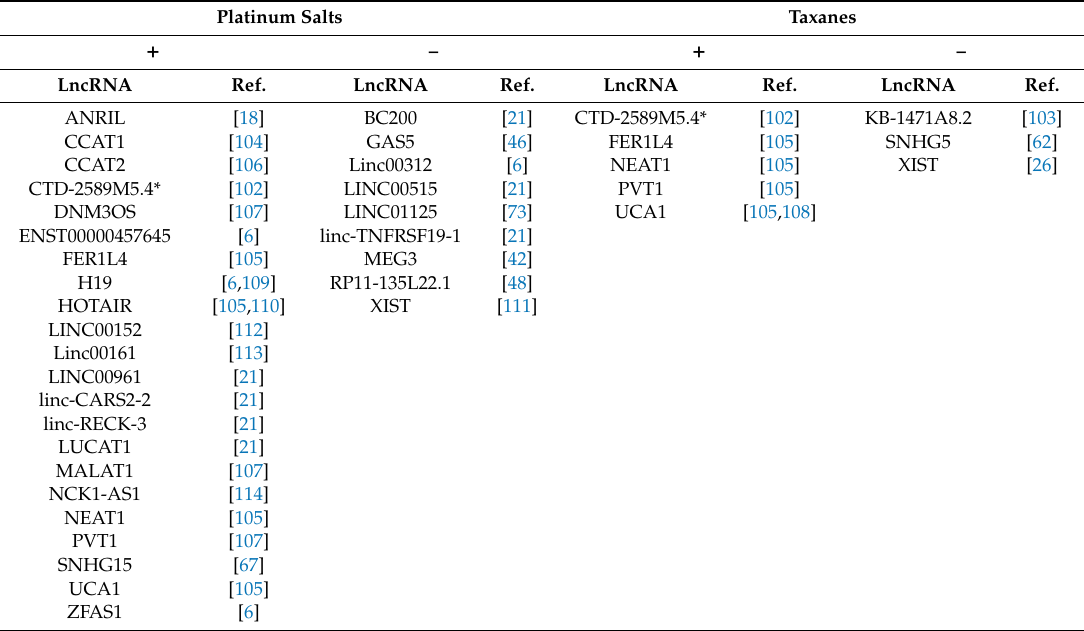
Table 4. LncRNAs associated with resistance to most common chemotherapeutic drugs. Platinum